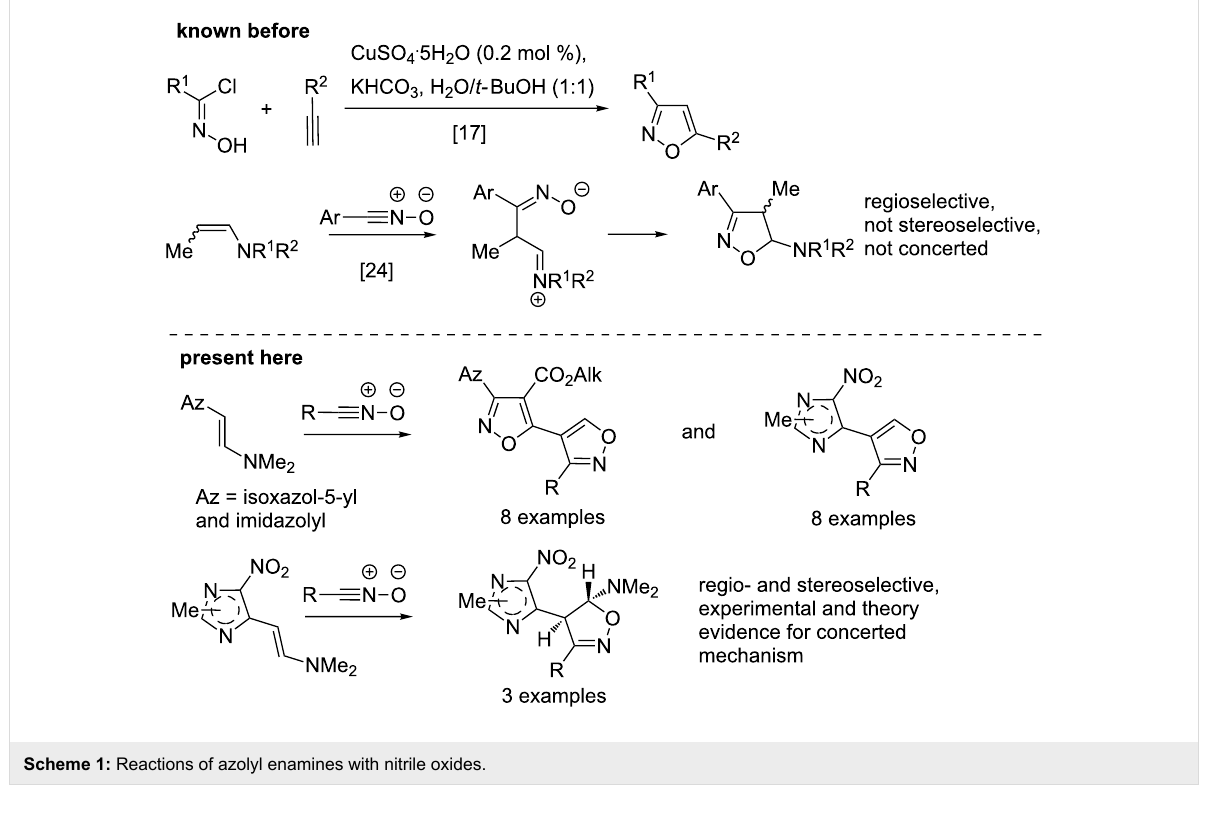
Scheme 1: Reactions of azolyl enamines with nitrile oxides.